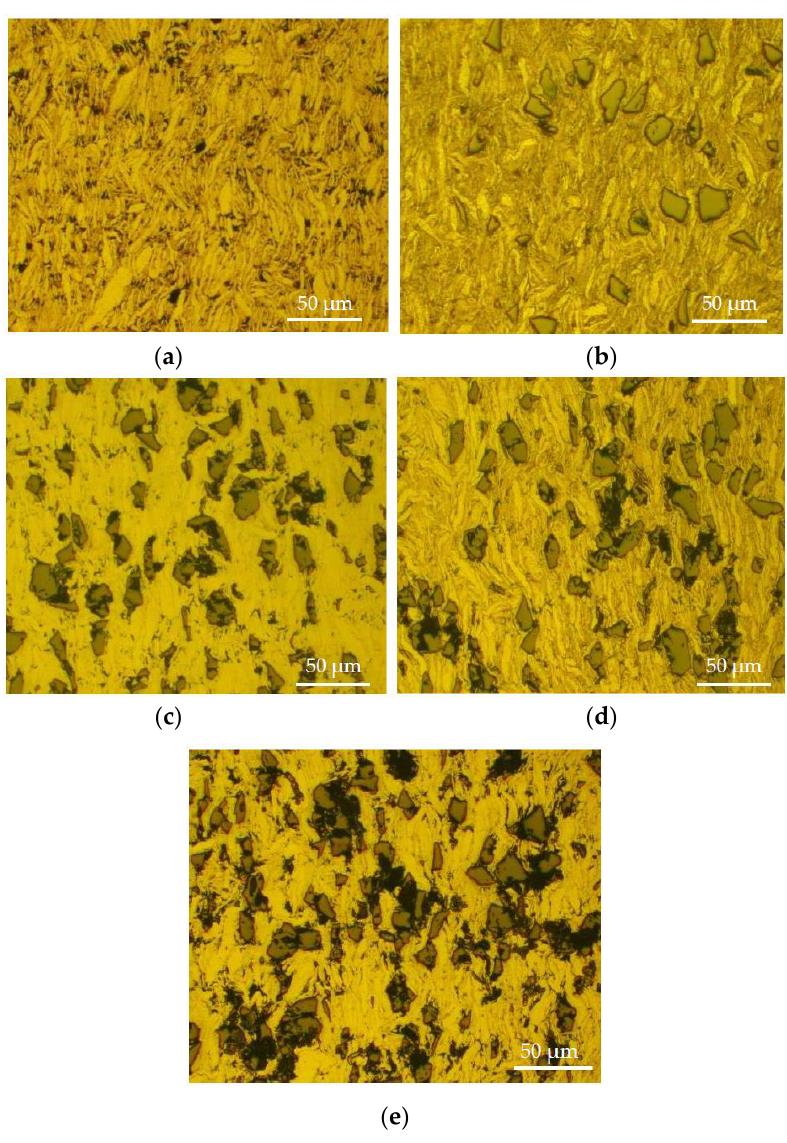
Figure 4. Optical micrographs of unsintered Fe/B 4 C composites: ( a ) 100 vol.% Fe; ( b ) Fe + 5 vol.% B 4 C; ( c ) Fe + 10 vol.% B 4 C; ( d ) Fe + 20 vol.% B 4 C; ( e ) Fe + 30 vol.% B 4 C. ( c ) Fe + 10 vol.% B + 20 vol.% B + 30 vol.% B 4 C; ( d ) Fe 4 C; ( e ) Fe 4